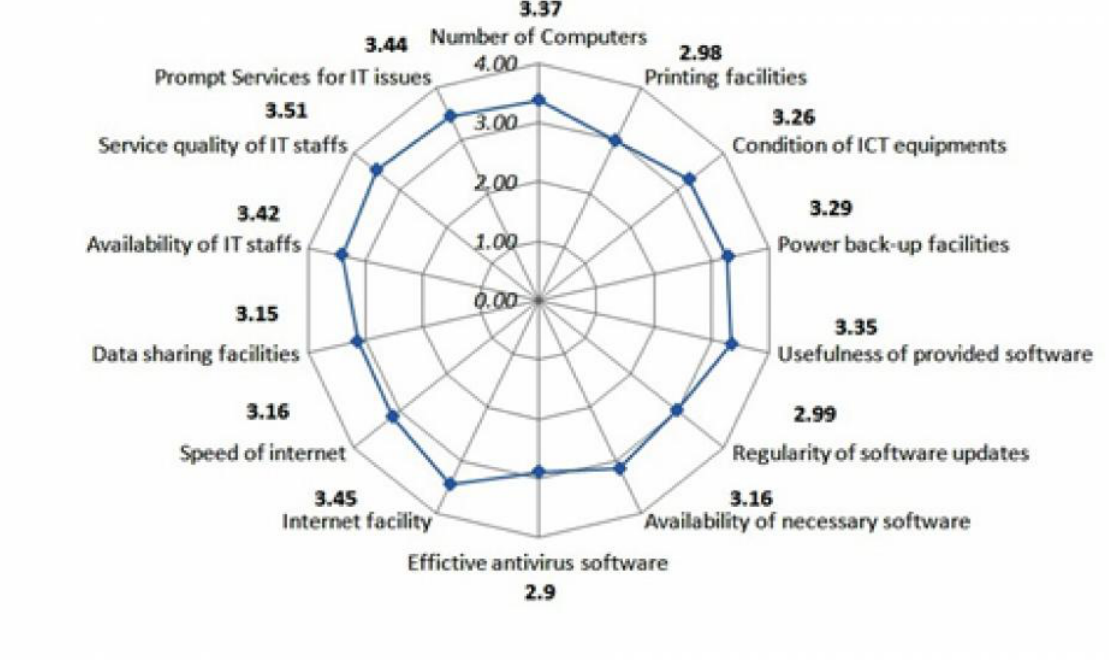
Fig. 1: Radar graph of the mean values of the